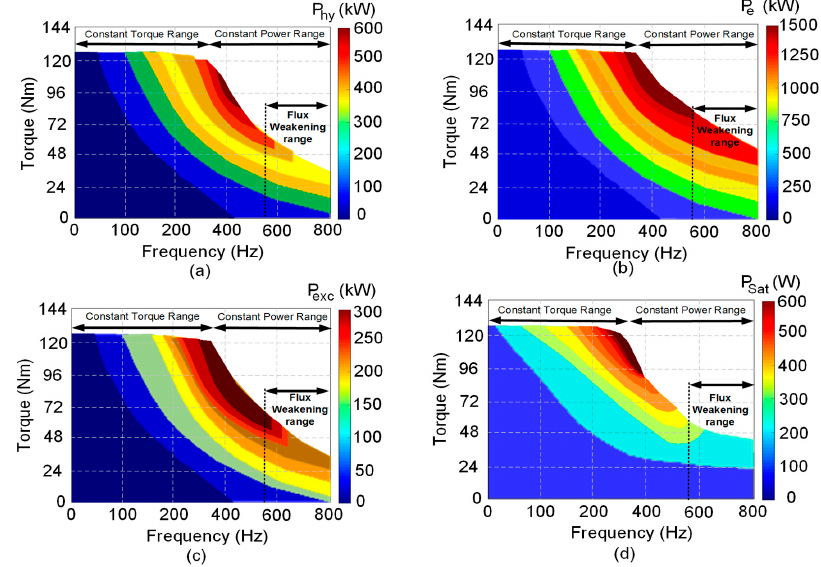
Figure 6. Predicted iron losses using modified IEM-Formula as function of torque and frequency, where: ( a ) the hysteresis loss; ( b ) the eddy-current loss; ( c ) excess loss contribution; and ( d ) saturation loss.